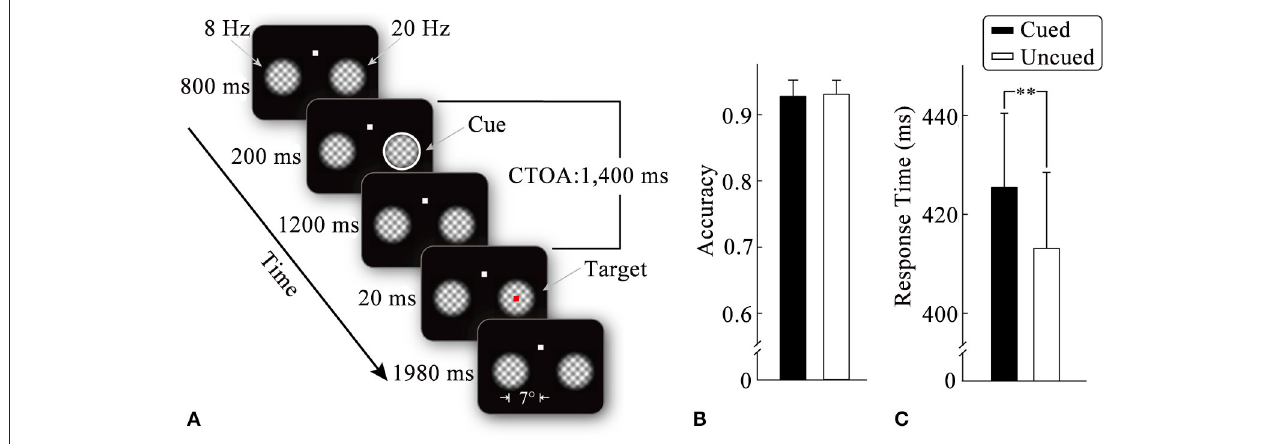
FIGURE 1 | Stimulus display sequences in an example trial (A) . Mean detection scores (B) and response times (C) for target stimulus as a function of the cueing condition. Standard error bars are shown. ** p < 0.01.